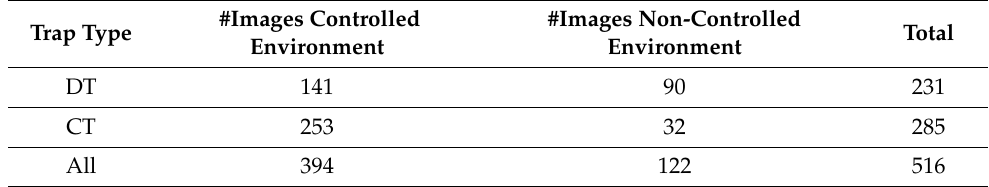
Table 1. Dataset image distribution regarding acquisition environment and trap type.